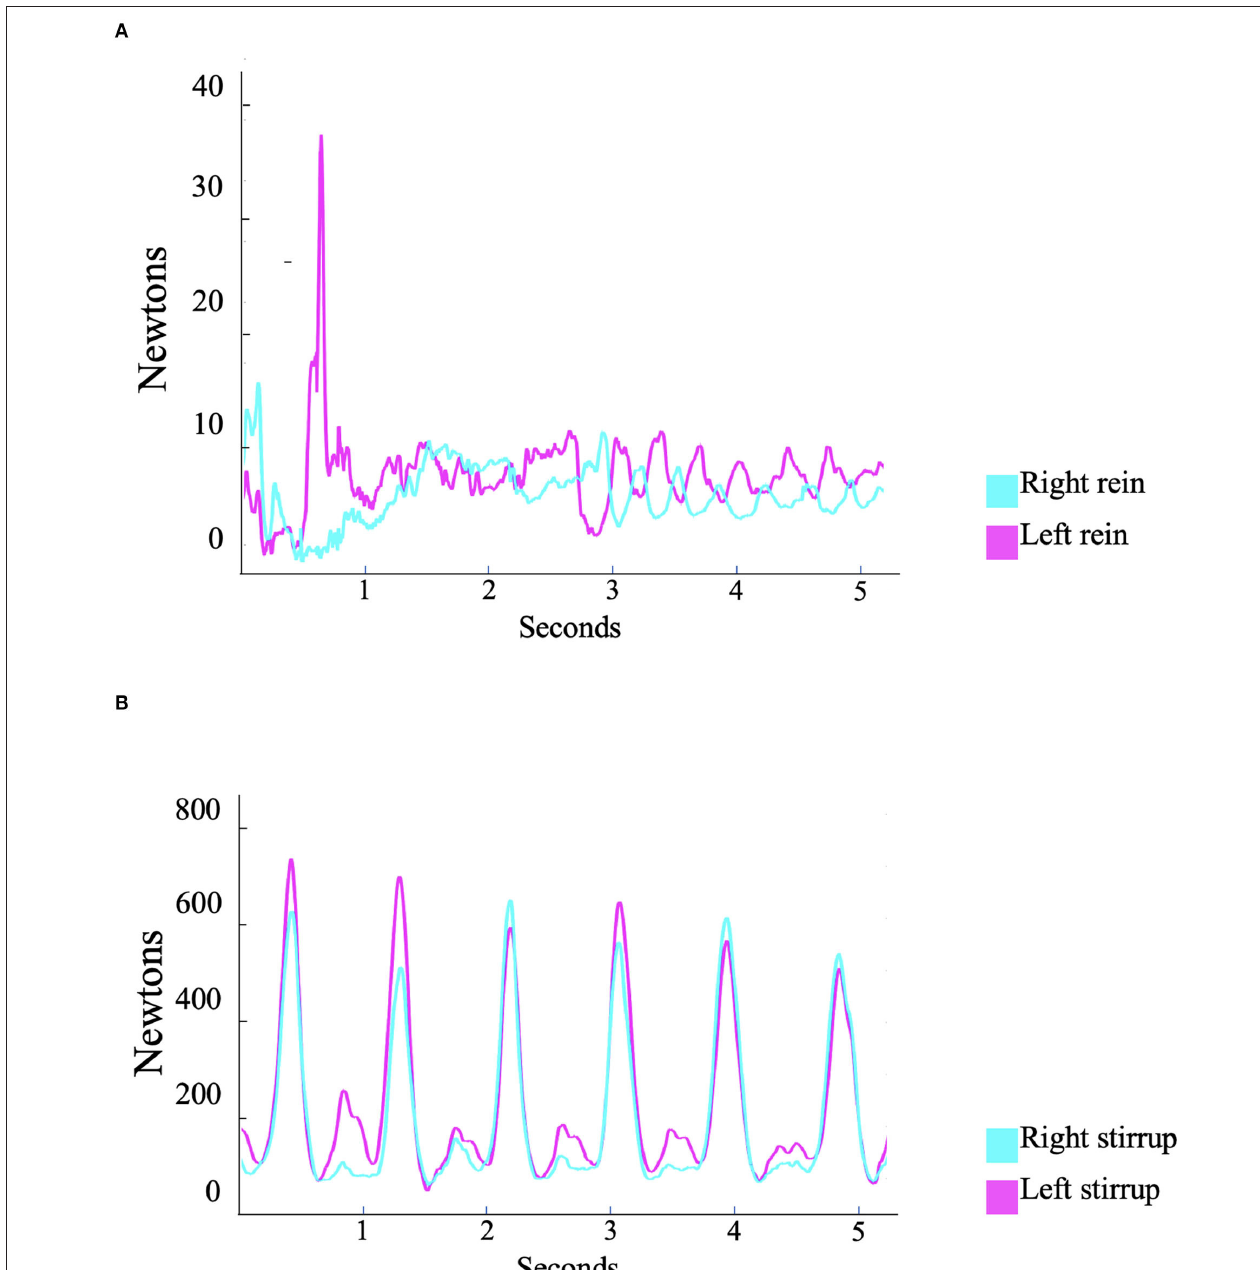
FIGURE 1 | Real-time feedback on the tension exerted at the (A) reins and (B) stirrups of a representative subject while being coached to achieve steady and balanced forces. The feedback included rein and stirrup forces displayed as a time-series line chart. With this implementation, the rider was able to continuously visualize how hard or soft he or she was in pushing down the stirrups or pulling on the